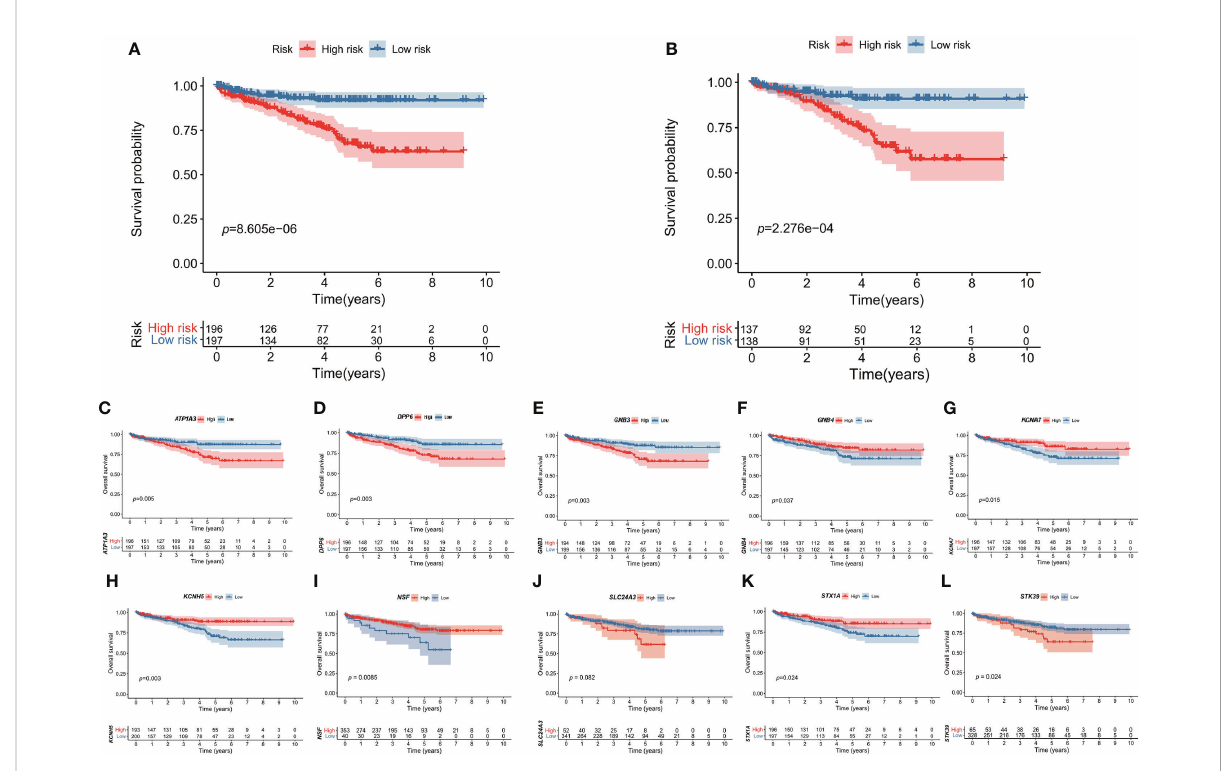
FIGURE 3 Kaplan – Meier survival curves of the high-risk and low-risk groups. The overall survival of the high-risk group was signi fi cantly lower than that of the low-risk group in the (A) training cohort and (B) validation cohort. The effect of each gene (C – L) expression value on OS in the prognostic